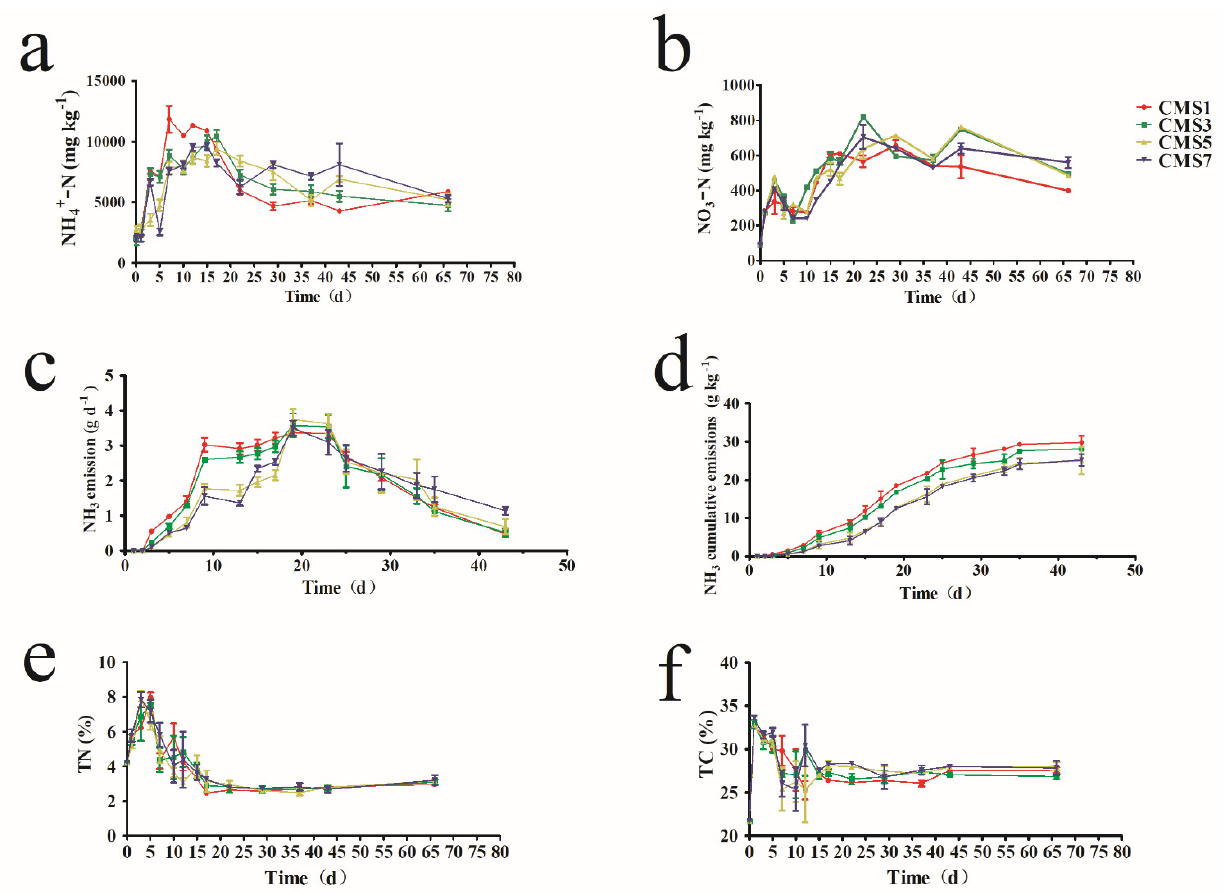
Figure 2. Variation in ammonium nitrogen ( a ), nitrate nitrogen ( b ), NH 3 emission rate ( c ), cumulative NH 3 emission ( d ), TN ( e ) and TC ( f ) in different treatments during the composting. Every data point represents the mean of three replicates. Bars indicate the SDs of the means.